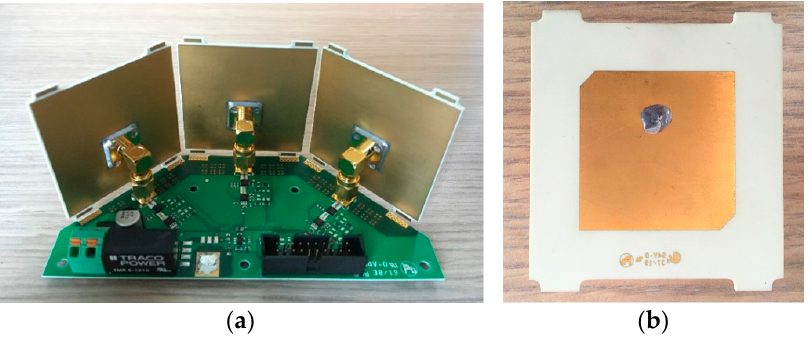
Figure 2. ( a ) Picture of the illuminator feeding circuitry working in the 2.4 GHz band [21] © 2020 IEEE; ( b ) front view of one of the three coaxial-fed circularly polarized patch antennas.